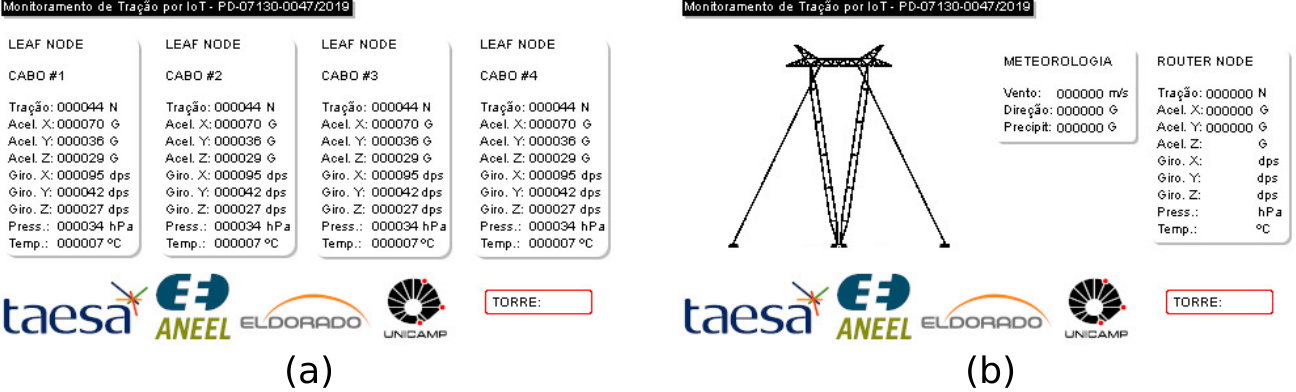
Figure 12. User interface samples from the border node HMI: ( a ) real-time information from leaf nodes; ( b ) real-time information from the router node and weather